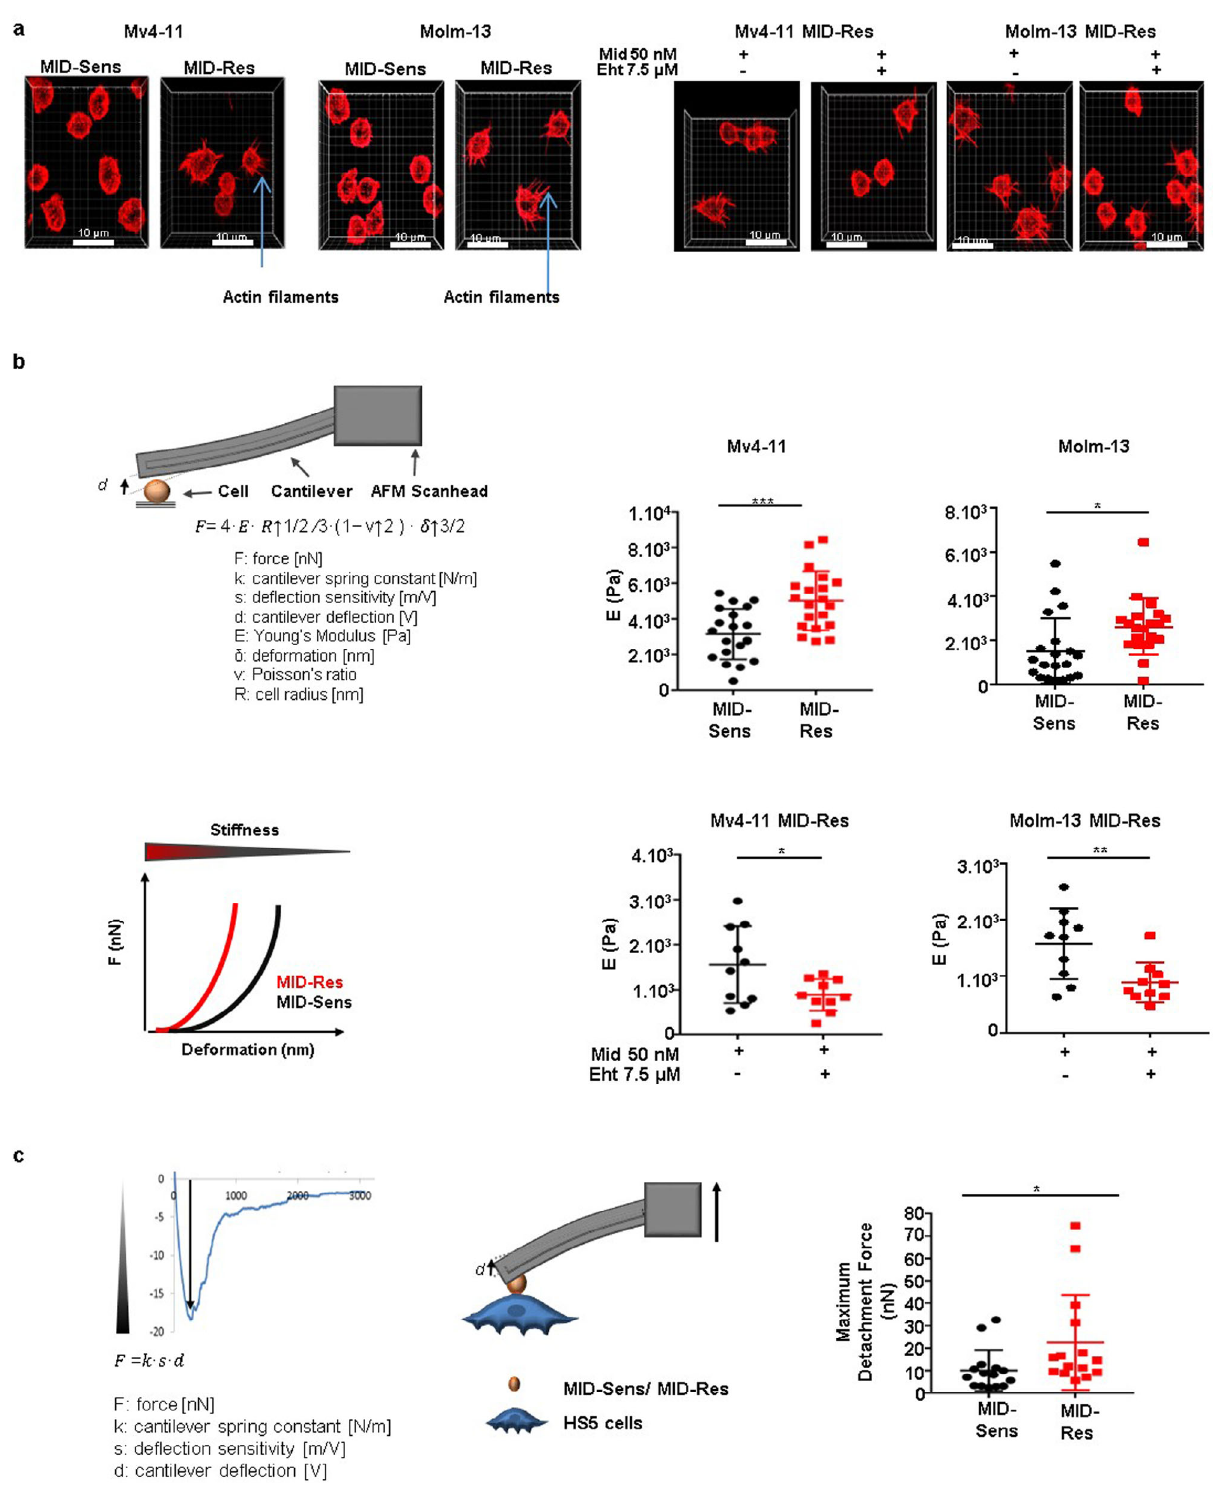
Fig. 4 Deregulation of cell mechanical properties and enhancement of cell adhesion to mesenchymal stromal HS-5 cells in MV4-11/MOLM-13 Midostaurin-resistant cells compared to sensitive cells. a Actin fi laments visualization in MV4-11/MOLM-13 MID-Res versus MID-Sens cells and MV4- 11/MOLM-13 MID-Res treated with the combination 50 nM Mid + 7.5 µ M Eht versus MID-Res treated with 50 nM Mid + DMSO during 24 h. b Cell stiffness analysis in MV4-11/MOLM-13 MID-Res compared to MID-Sens cells ((MV) p < 0.001, F = 14.8, df = 1, (MO) p < 0.05, F = 6.4, df = 1) and in MV4-11/MOLM-13 MID-Res treated with the combination 50 nM Mid + 7.5 µ M Eht versus MID-Res treated with 50 nM Mid + DMSO (vehicle control) during 24 h ((MV) p < 0.05, F = 5.3, df = 1, (MO) p < 0.01, F = 9.3, df = 1)*. c Cell adhesion forces quanti fi cation in MV4-11 MID-Sens/HS-5 cells and MV4-11 MID-Res/HS-5 ( p < 0.05, F = 4.3, df = 1)*. Data are shown as means ± SDs (error bars) from three independent experiments. *Due to technical limitations, EHT1864 monotherapy was not performed in stiffness/cell adhesion assays.